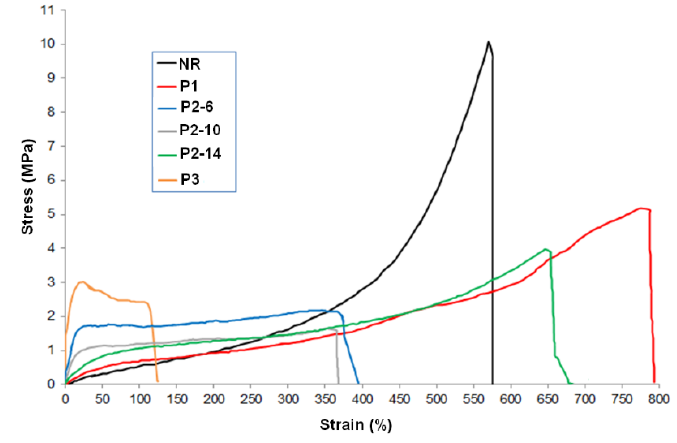
Fibers 2021 , 9 , x FOR PEER REVIEW Figure 5. Typical tensile curves for different categories of samples. Figure 5. Typical tensile curves for different categories of samples.